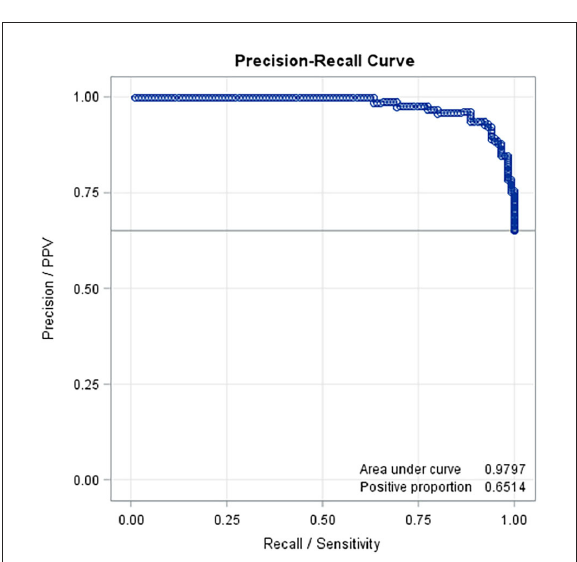
FIGURE3 Precision-recall curve based on the results of the prediction equation obtained with the variables selected with the stepwise method (AUC =